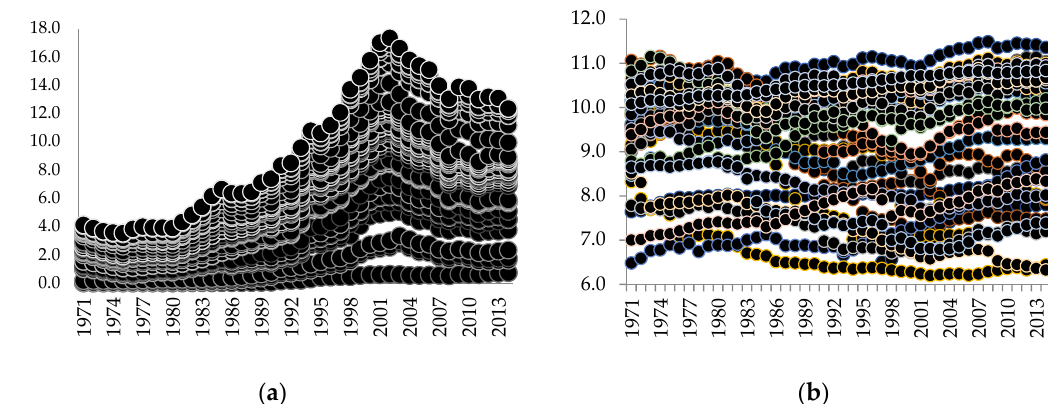
Figure 2. ( a ) Log(energy intensity); ( b ) log(per-capita GDP). Note: The trends in energy intensity and real GDP per capita for the sample of 48 countries used in this study.